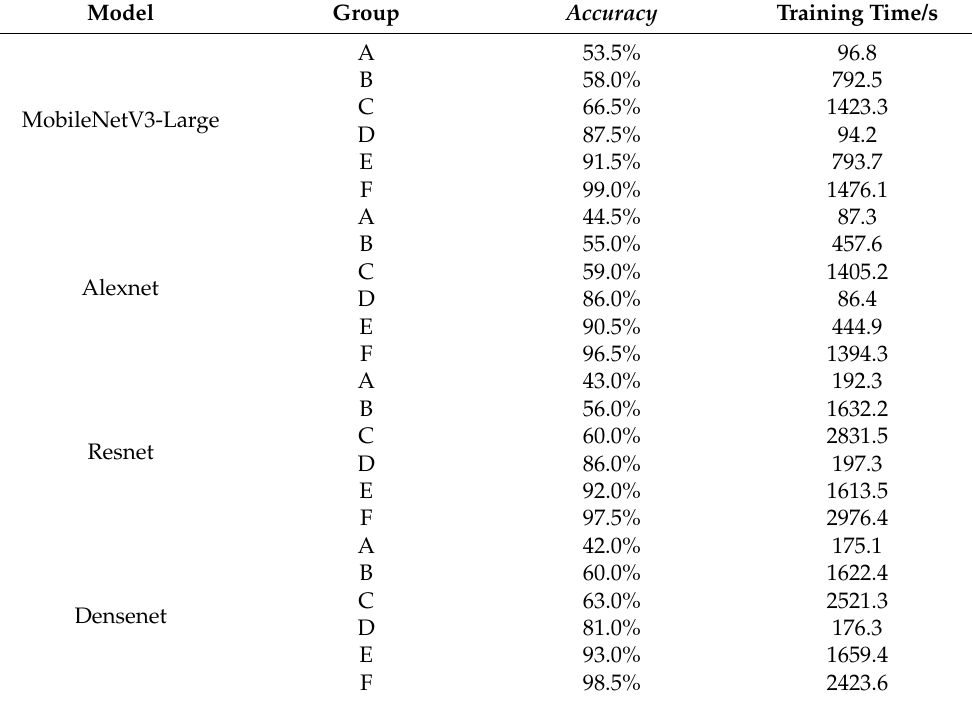
Table 8. Performance comparison of the networks trained by the six groups of